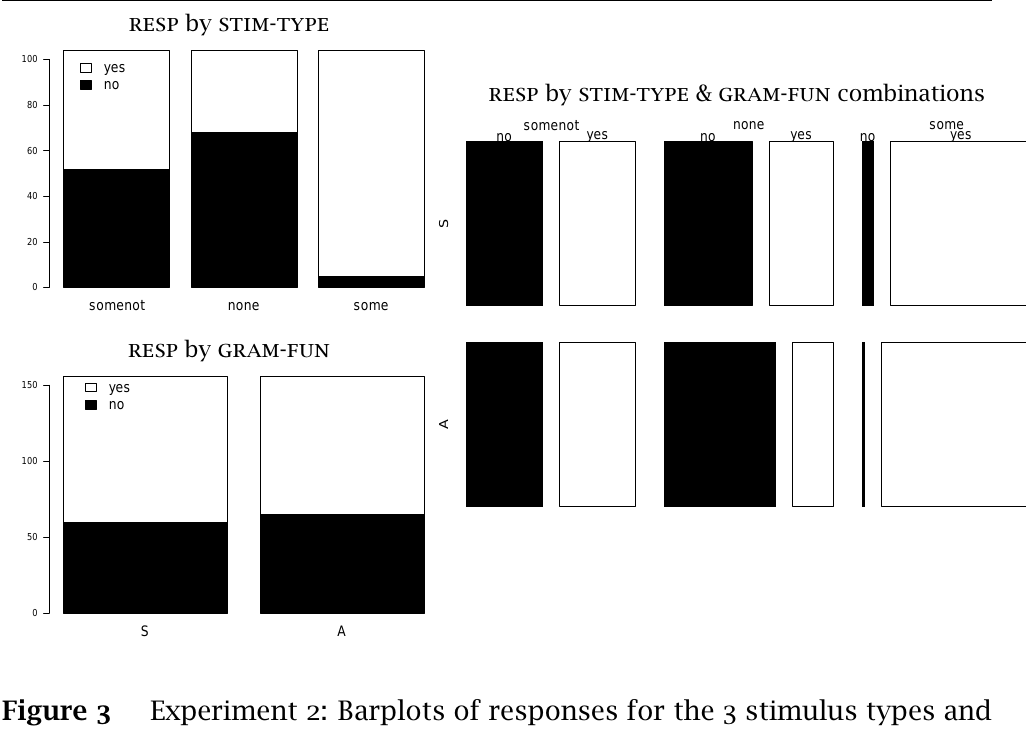
Figure 3 Experiment 2 : Barplots of responses for the 3 stimulus types and the 2 grammatical functions, and mosaic plot of responses for the 6 stimulus type & grammatical function